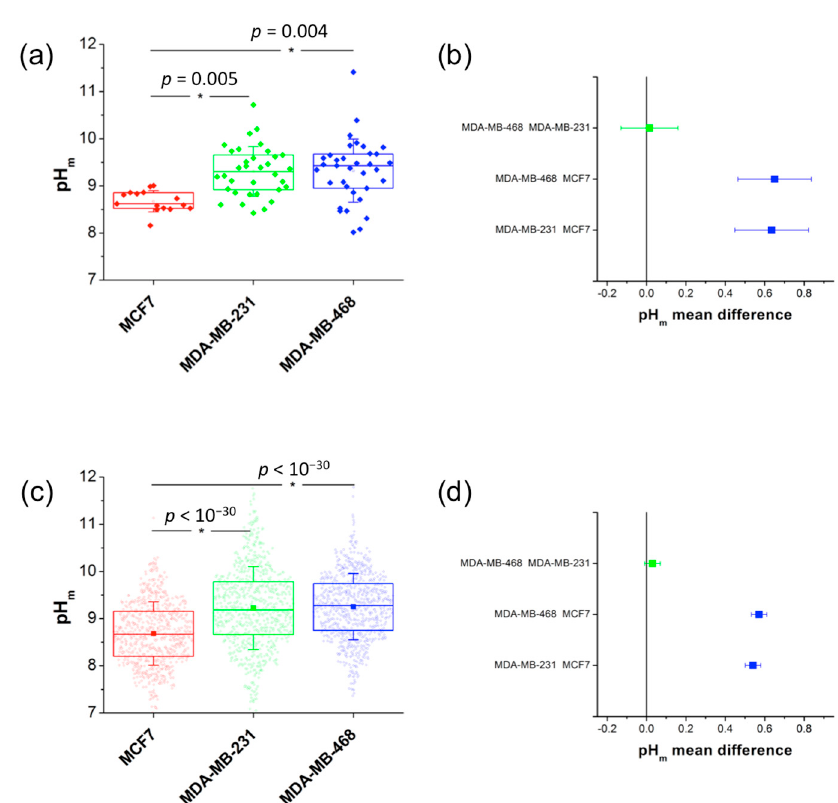
Figure 4. ( a and c ) Box plot of the pH m distributions obtained in different image repetitions ( a ) and obtained pixelwise ( c ), where the box includes 75% of the images or pixels, respectively, and the whiskers represent the standard deviations. ( b and d ) Differences in the means of the pH m distributions obtained in different image repetitions ( b ) and obtained pixelwise ( d ). The distributions were compared using the Bonferroni statistical test at a significance level of 0.01. The asterisks in panels ( a ) and ( c ) indicate that the marked distribution is significantly different from the other two. In panels ( b ) and ( d ), blue squares indicate significant differences, whereas green squares represent nonsignificant differences.